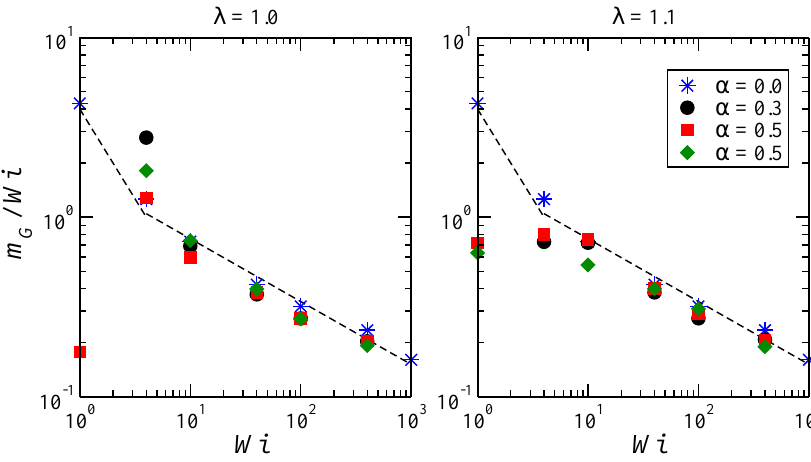
Figure 6. Reduced orientational resistance m G / Wi for stars with f = 18, N pol = 40 and values of λ and α as indicated on the panels. For athermal stars, we find m G / Wi ∼ Wi − 0.83 at small Wi , and m G / Wi ∼ Wi − 0.30 at large Wi